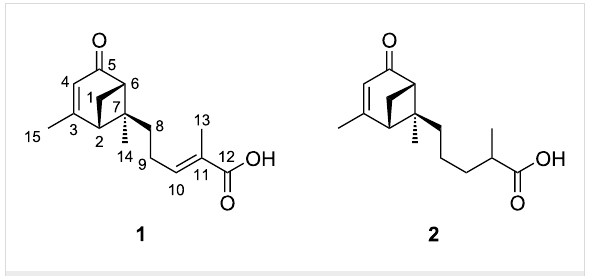
Figure 1: Secondary metabolites isolated from H. cf. alpina